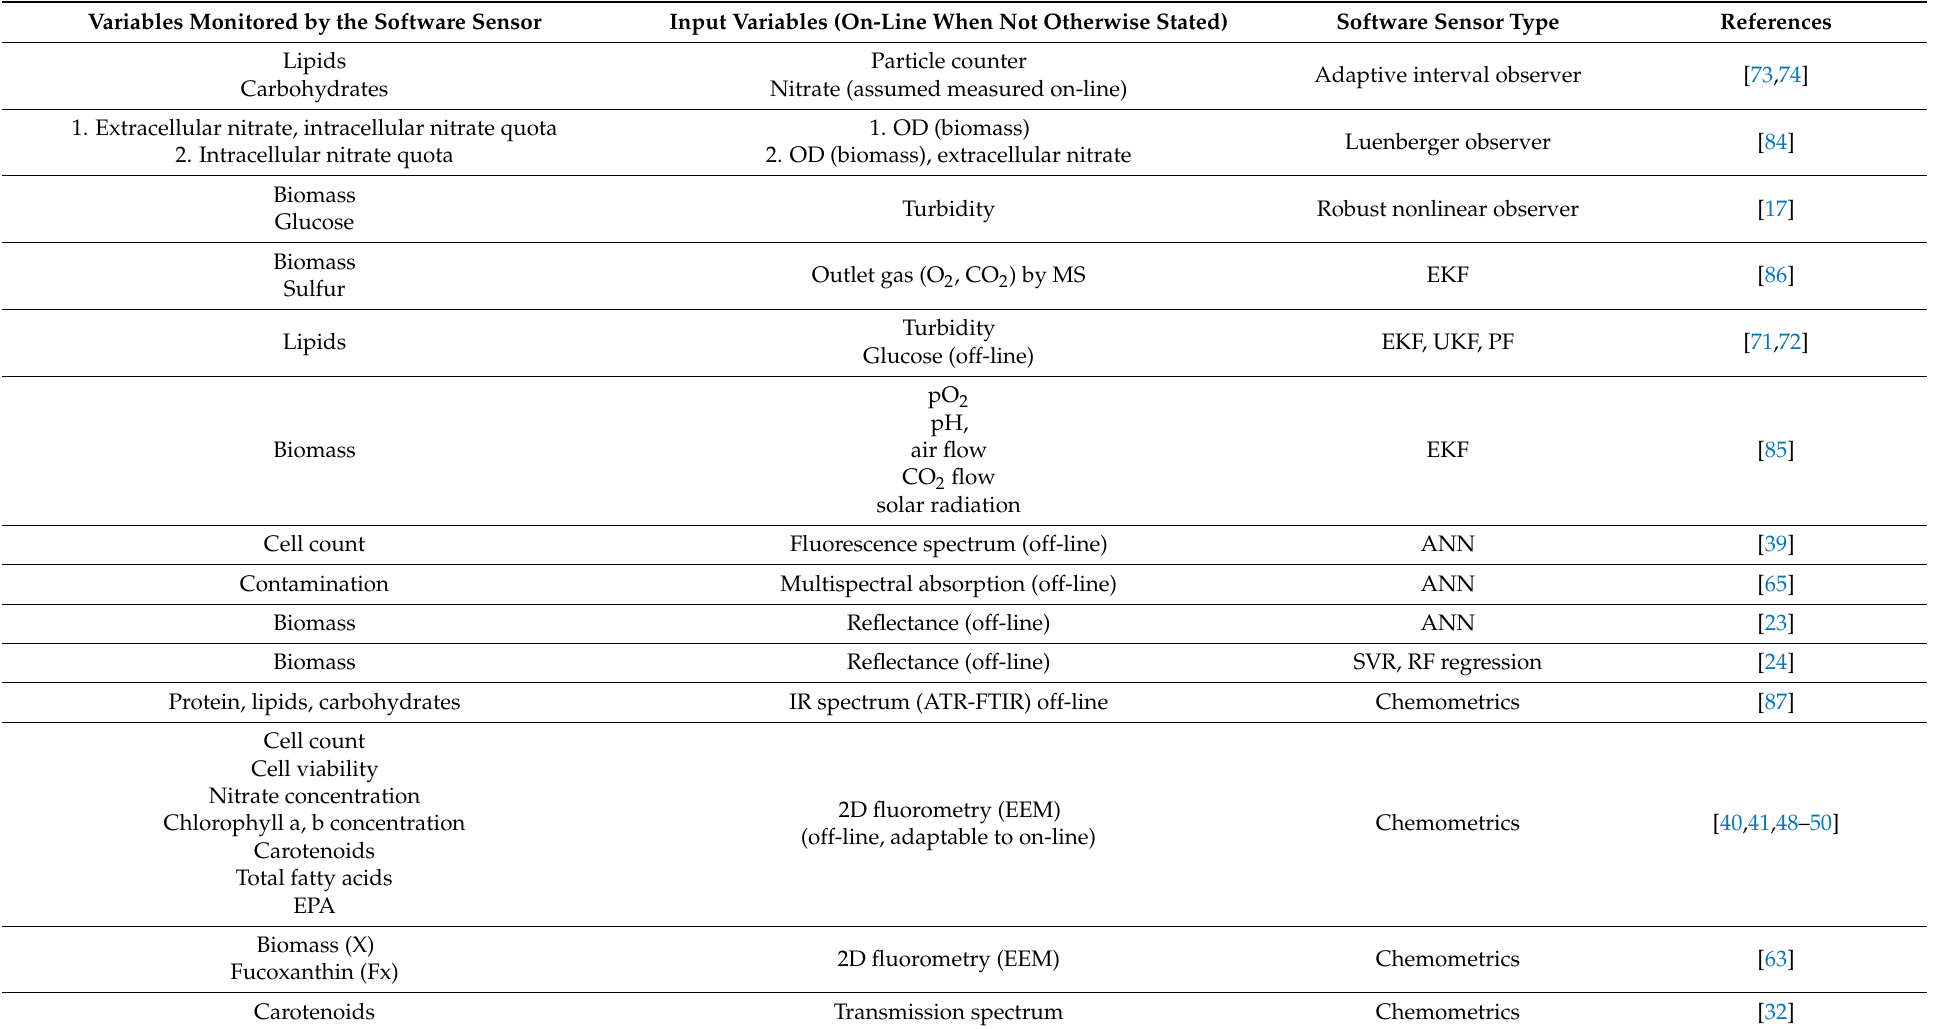
Table 3. Software sensors monitoring biologically important variables in microalgal